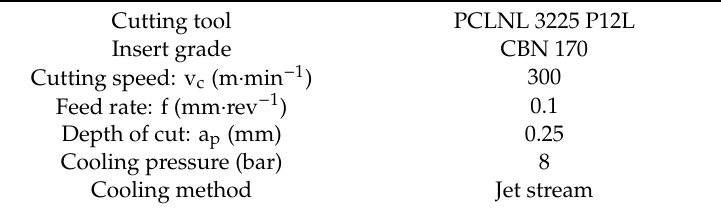
Figure 3. ( a ) Experimental setup and ( b ) tool geometry and jet stream cooling configuration. Table 2. Test conditions and parameters. CBN: cubic boron